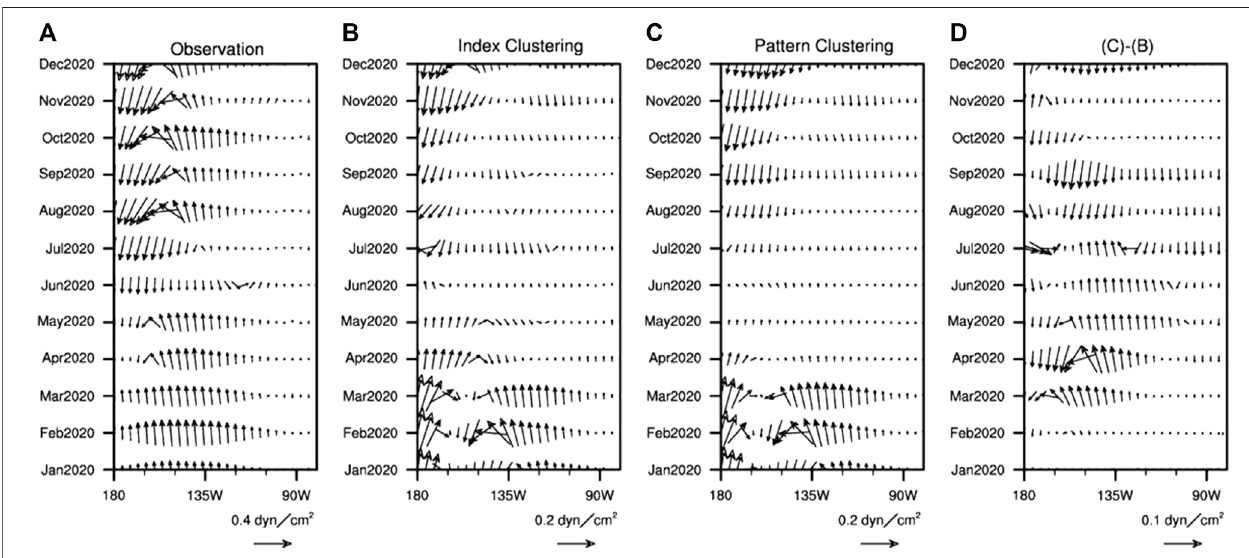
Figure 6 . From the observations, the entire equatorial Paci fi c was